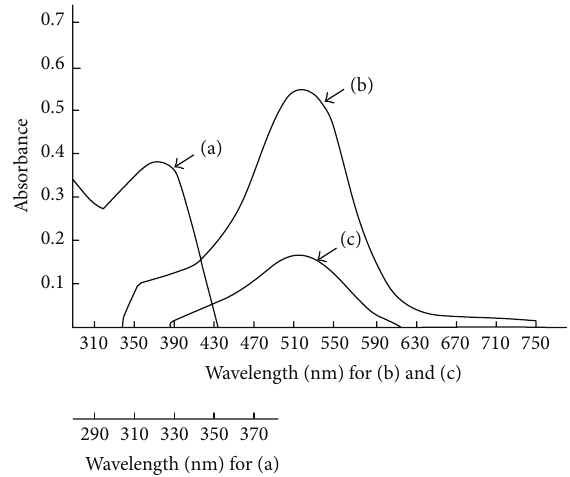
Figure 1: Absorption spectra for the complexes of 0.5mL of 1 × 10 −3 M TCNQ with (a) 2 𝜇 g/mL aniline, (b) 2 𝜇 g/mL p- aminophenol, and (c) 0.75 𝜇 g/mL benzidine versus blank reagent.